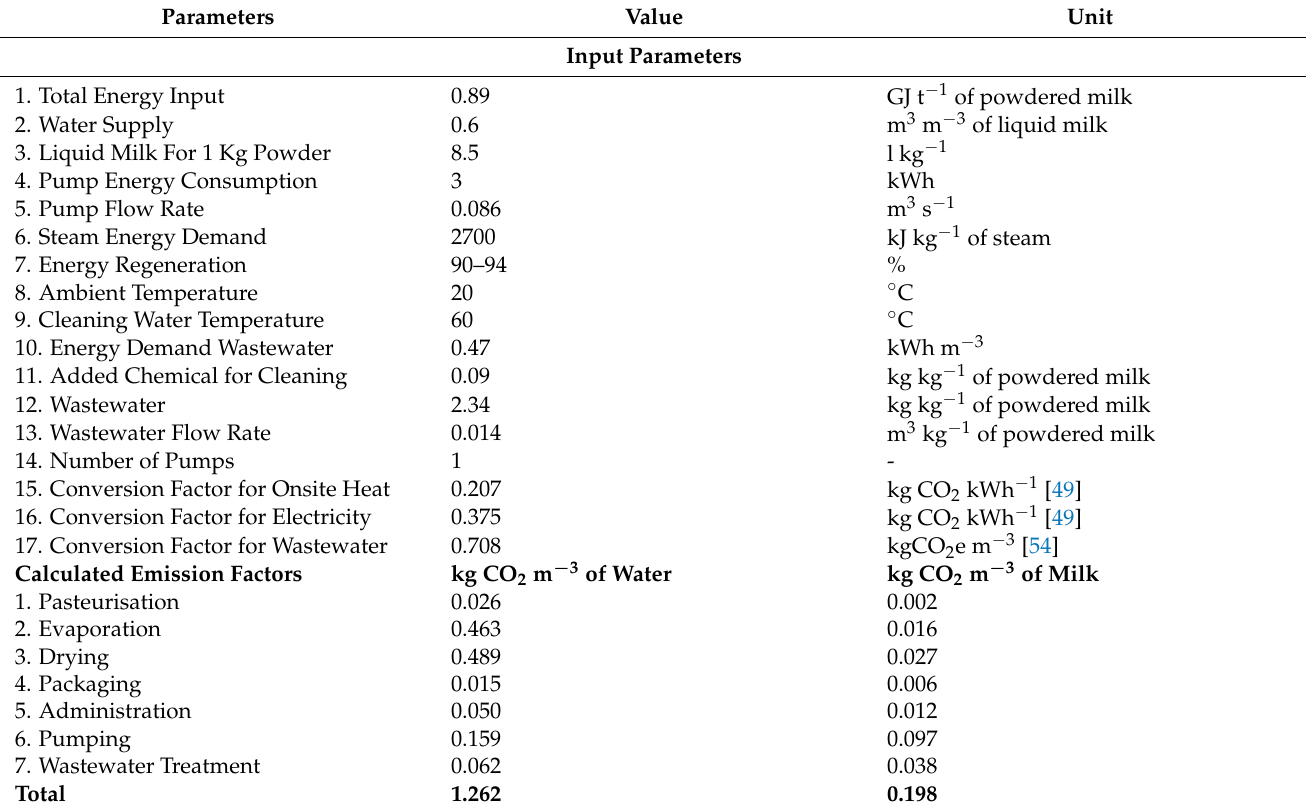
Table 5. Results of the carbon footprint calculation in milk dairy production